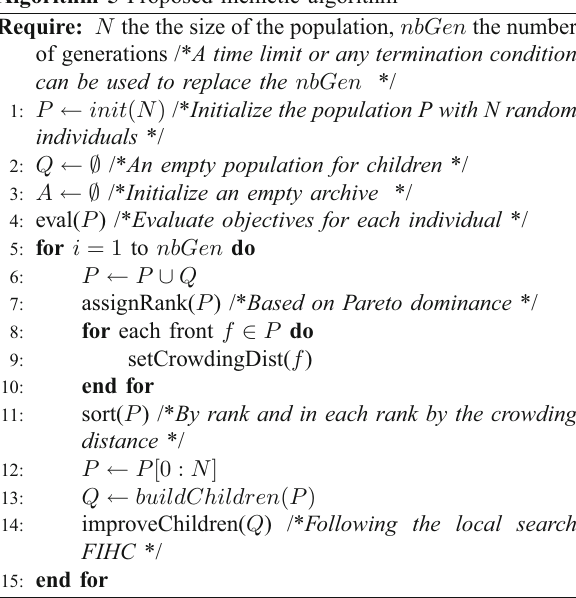
Algorithm 5 Proposed memetic